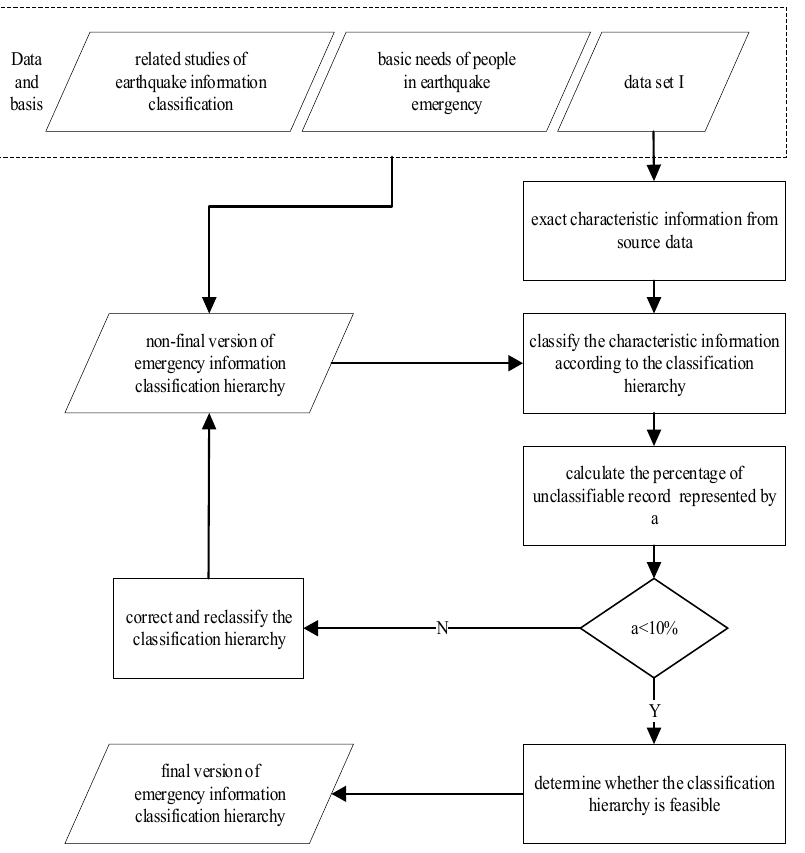
Figure 2. Construction process of the earthquake emergency information classification hierarchy.